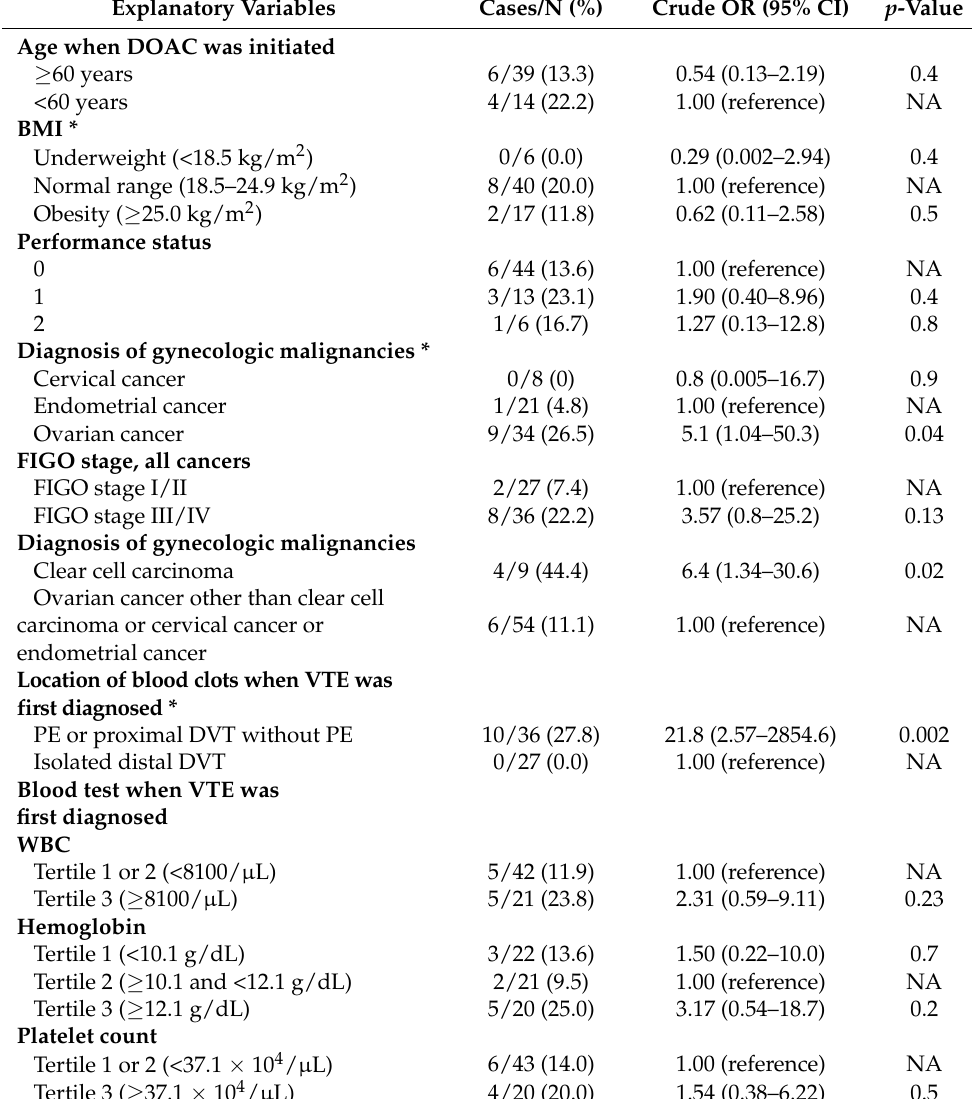
Table 5. Results of the univariate logistic regression